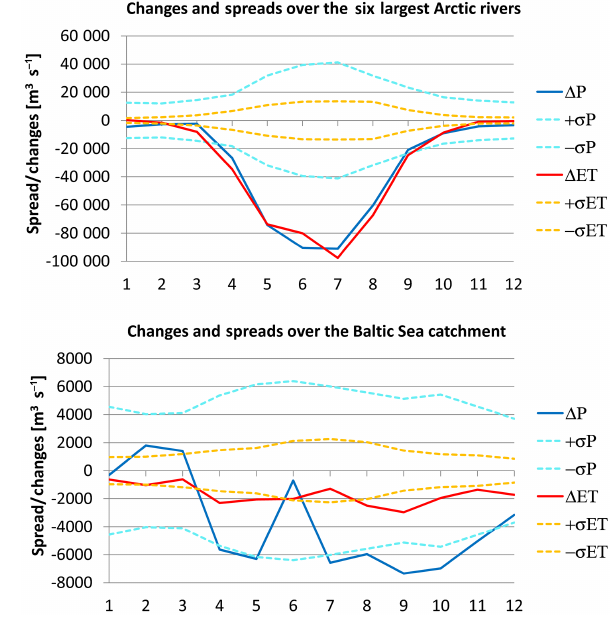
Figure 8. Mean monthly climatological differences (1989–2009) between ECH6-PF and ECH6-REF for precipitation ( (cid:49)P ) and evapotranspiration ( (cid:49) ET) over the six largest Arctic rivers (upper panel) and the Baltic Sea catchment (lower panel). The dashed lines indicate the corresponding spreads obtained from MPI-ESM simu- lations of de Vrese and Hagemann